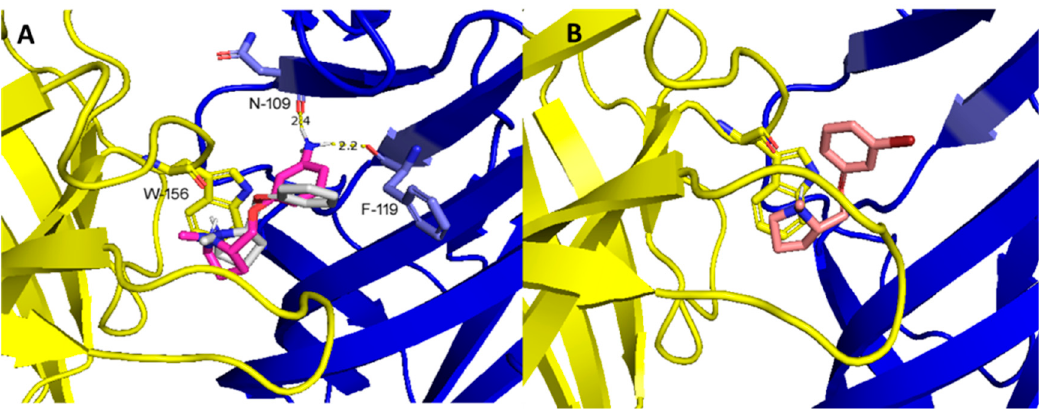
Figure 6. A: Superimposed structures of compounds 1 (grey), and 2 (magenta) docked into the agonist binding site of the α 4 β 2 nAChR. Compound 2 shows the additional interaction with β 2 N109 and β 2 F119. B: Binding mode of compound 4 (pink) into the binding site of the α 4 β 2 nAChR. The images show the π -cation interaction between the ligands and the α 4W156 in the opened channel state conformation (C loop closed).